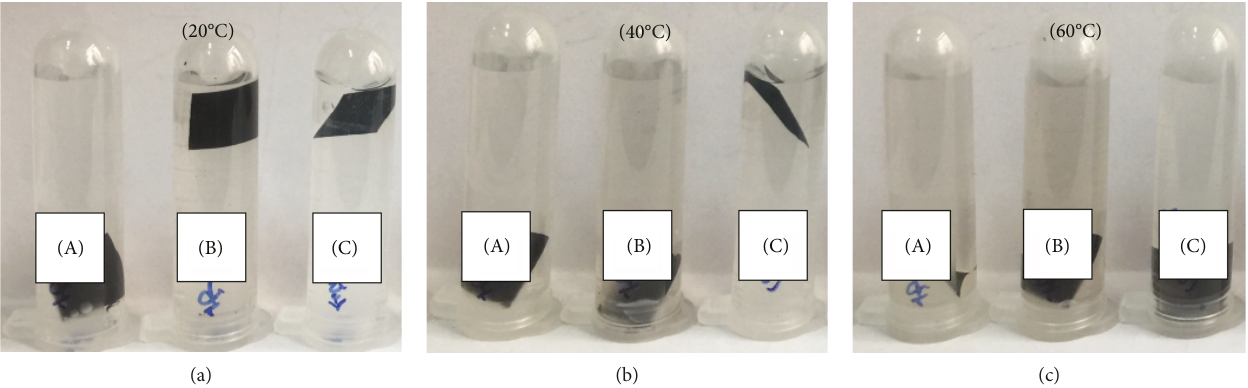
Figure 11: Water resistance test of di ff erent inks ((A) commercial 1; (B) commercial 2; (C) CGCe ink).